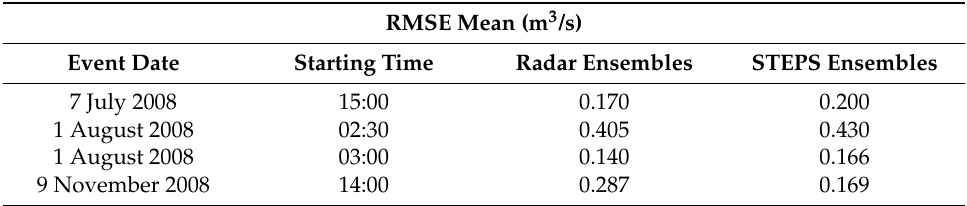
Figure 14. RMSE for radar and STEPS ensembles and 0 – 1 h after the start of the forecast. Table 2. RMSE mean for radar and STEPS ensembles for 0–1 h after the start of the forecast. RMSE Mean (m 3